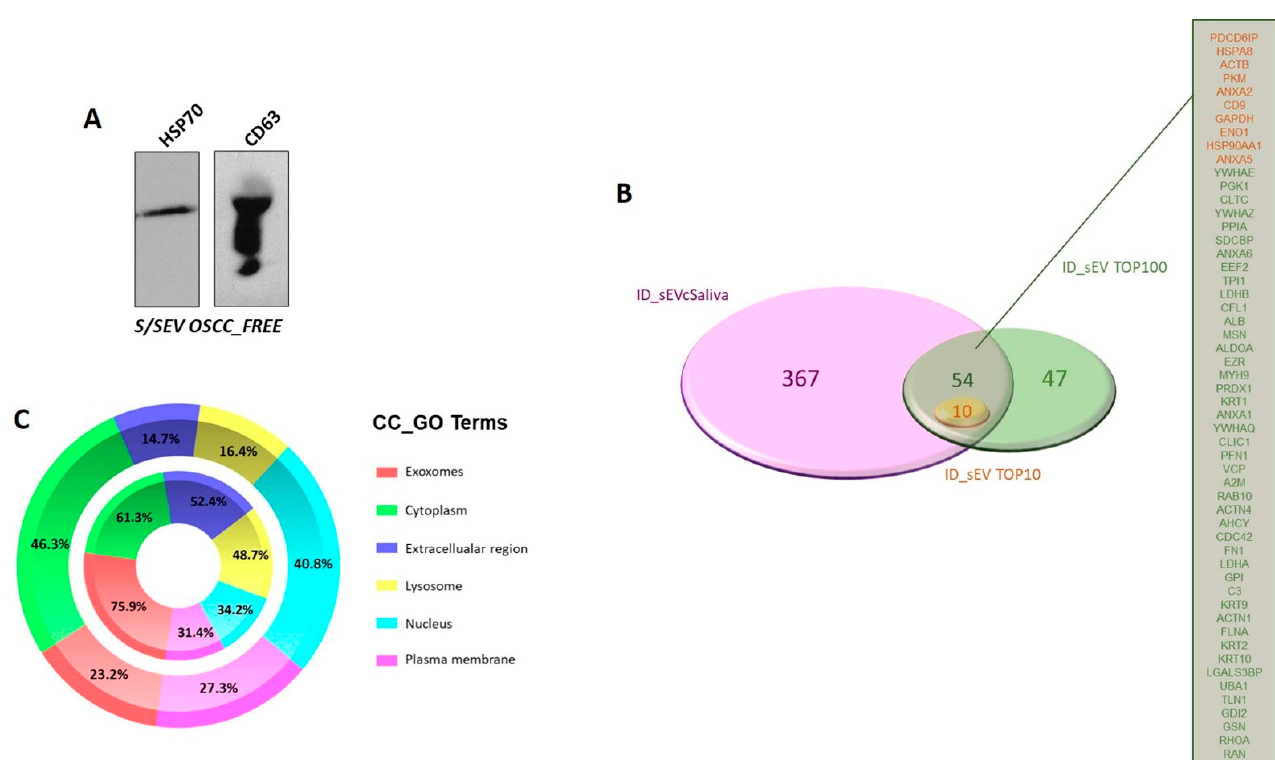
Figure 2. Workflow of the study.